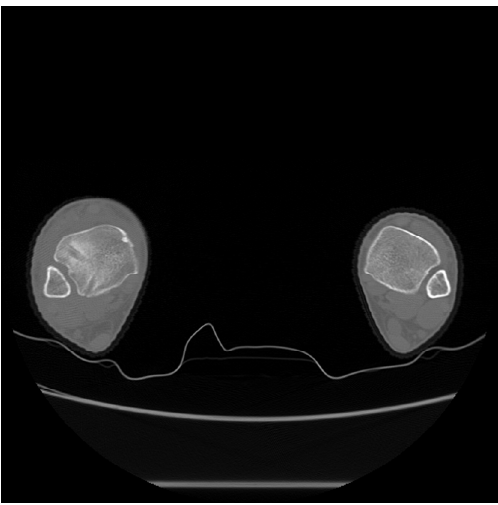
Figure 7. Axial computed tomography performed at the 6-month follow-up exam revealed similar alignment of the syndesmosis between the injured and uninjured sides.